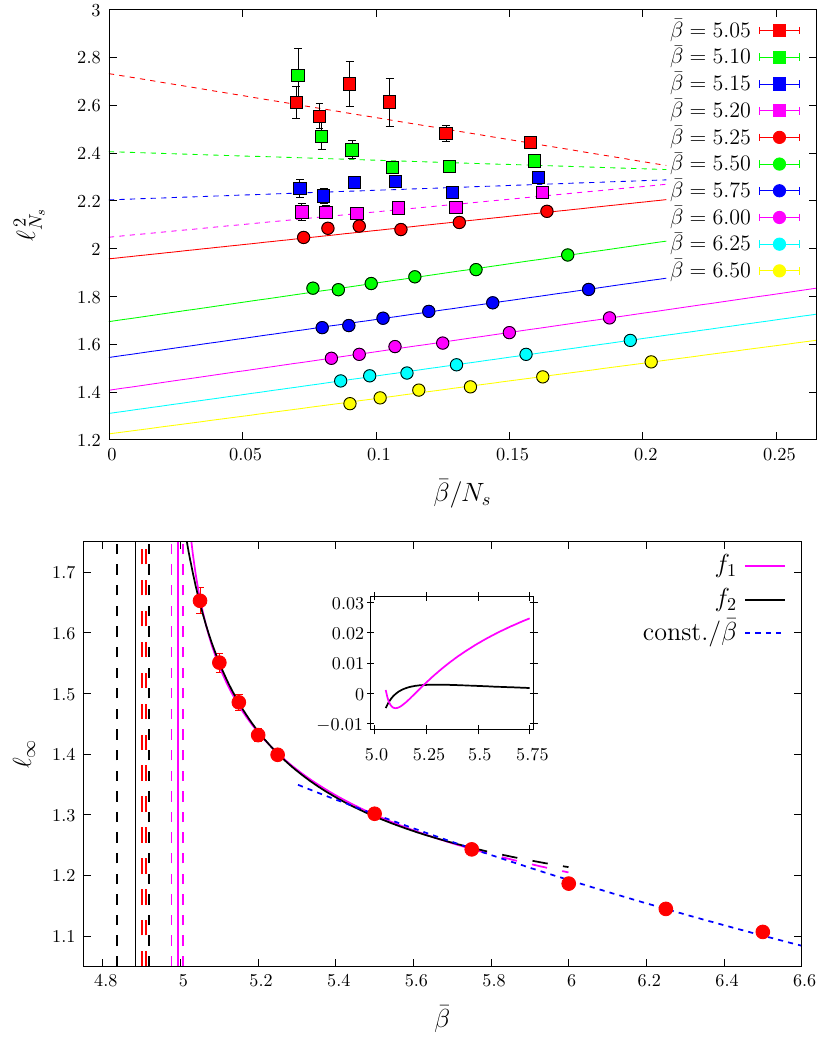
Figure 2 . Top panel: size ℓ 2 of the lowest mode in physical units as a function of the inverse N s linear size of the lattice, for various ¯ β in the deconfined phase. Linear fits are also shown with solid lines. Bottom panel: linear size ℓ ∞ extrapolated to infinite volume as a function of ¯ β . Fits to the near-¯ β (¯ β ) (magenta) and f (¯ β ) (black) given in eq. (4.2) are also shown. c data with the functions f 1 2 The corresponding fitted values for ¯ β 1 , 2 and the related error bands are marked by the vertical lines with corresponding colours. The error band for ¯ β c is also shown (red). In the inset it is shown the change in the fitting function due to changing the fitting interval (see